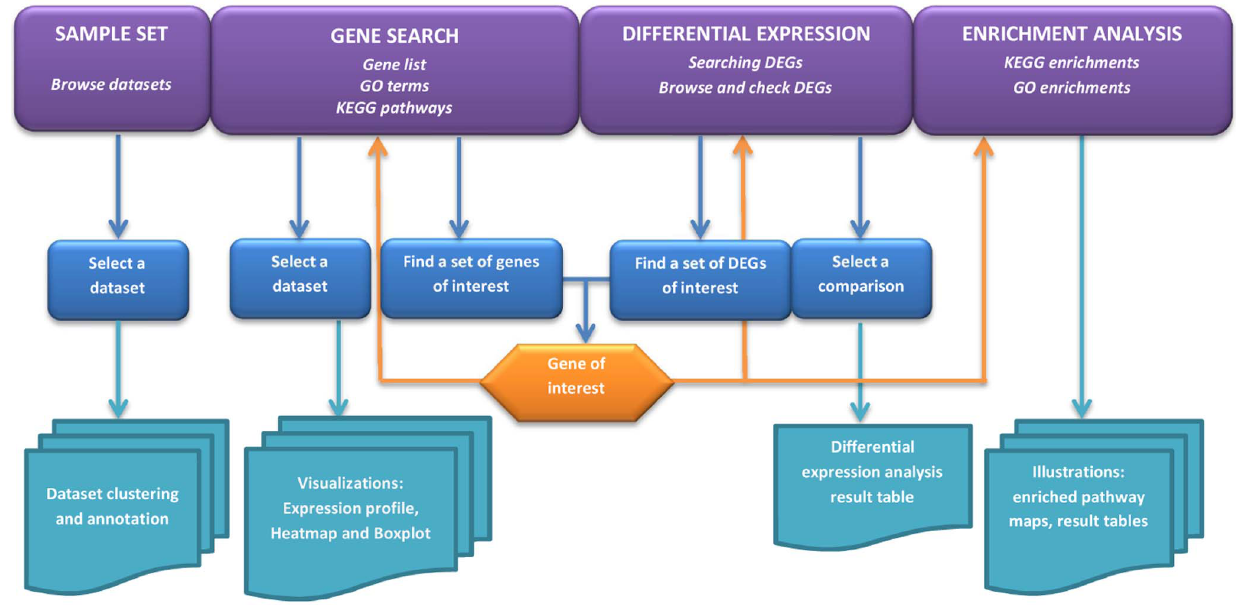
Figure 1. NanoMiner workflow diagram. NanoMiner provides several options to use the database: [1] SAMPLE SET: In the Sample Set section of the database it is possible to browse the datasets and cluster the samples within the datasets. In addition, in this section it is possible to download all the annotations of the dataset. [2] GENE SEARCH: In the Gene Search page the user can search a gene or set of genes based on the gene names on the Gene Ontology (GO) or KEGG pathways. Further, the user can plot gene expression profiles within a given dataset. There are three options for plotting the genes; expression values of all selected genes in one plot, heatmap of all selected gene values, or boxplot of each gene separately. [3] DIFFERENTIAL EXPRESSION: In the Differential Expression page, the user can find the differentially expressed genes (DEGs) in the pre-computed comparisons. In addition, it is possible to search for differentially expressed genes across several datasets by first selecting genes of interest and then analyzing their expression over the comparisons. [4] ENRICHMENT ANALYSIS: the user can identify the enriched KEGG-pathways and GO classes for the detected genes. Further, the enriched KEGG pathways can be illustrated by pathway maps.